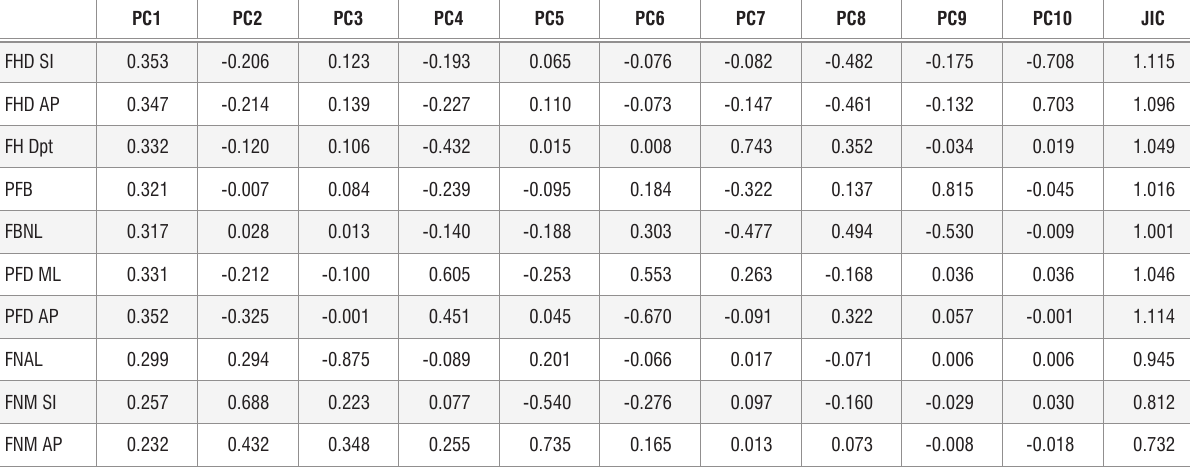
Component loadings for the principal components (PC) analysis of the proximal femur: pooled-sample raw data PC1